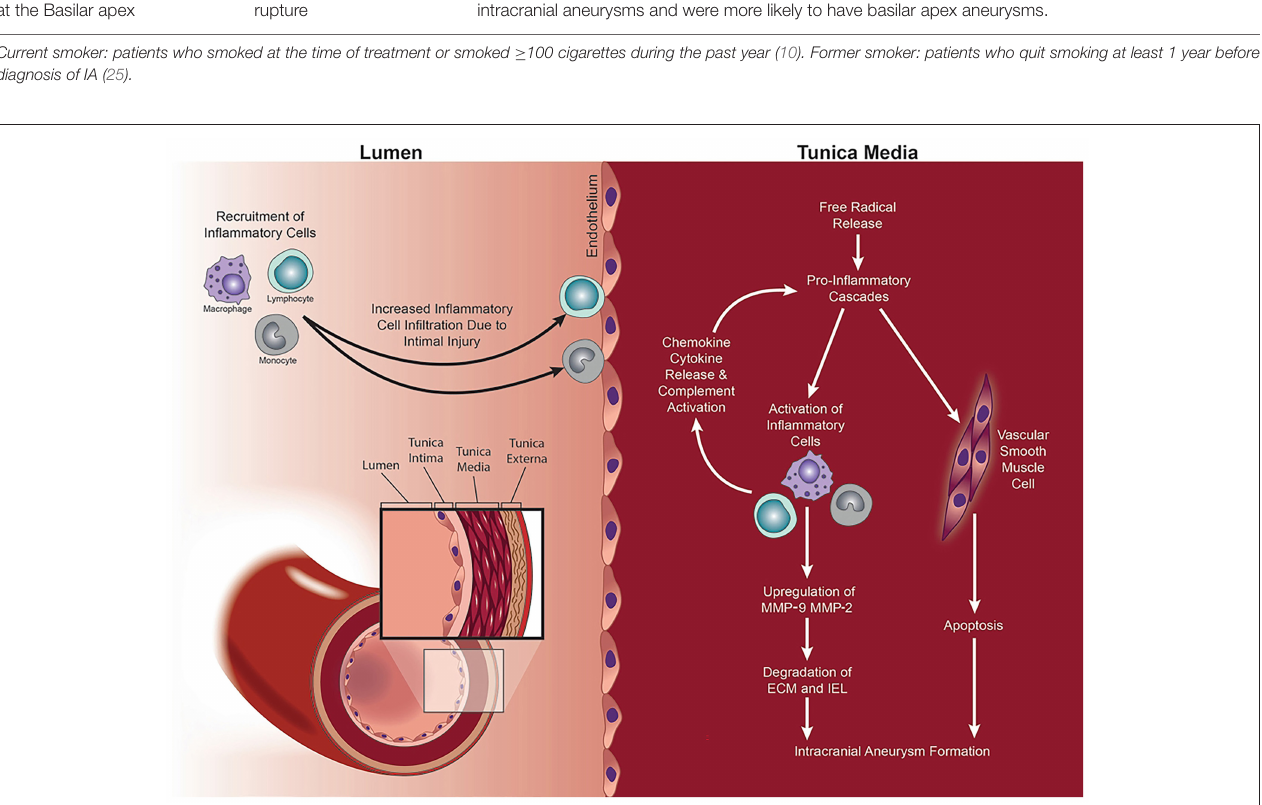
Frontiers in Neurology |